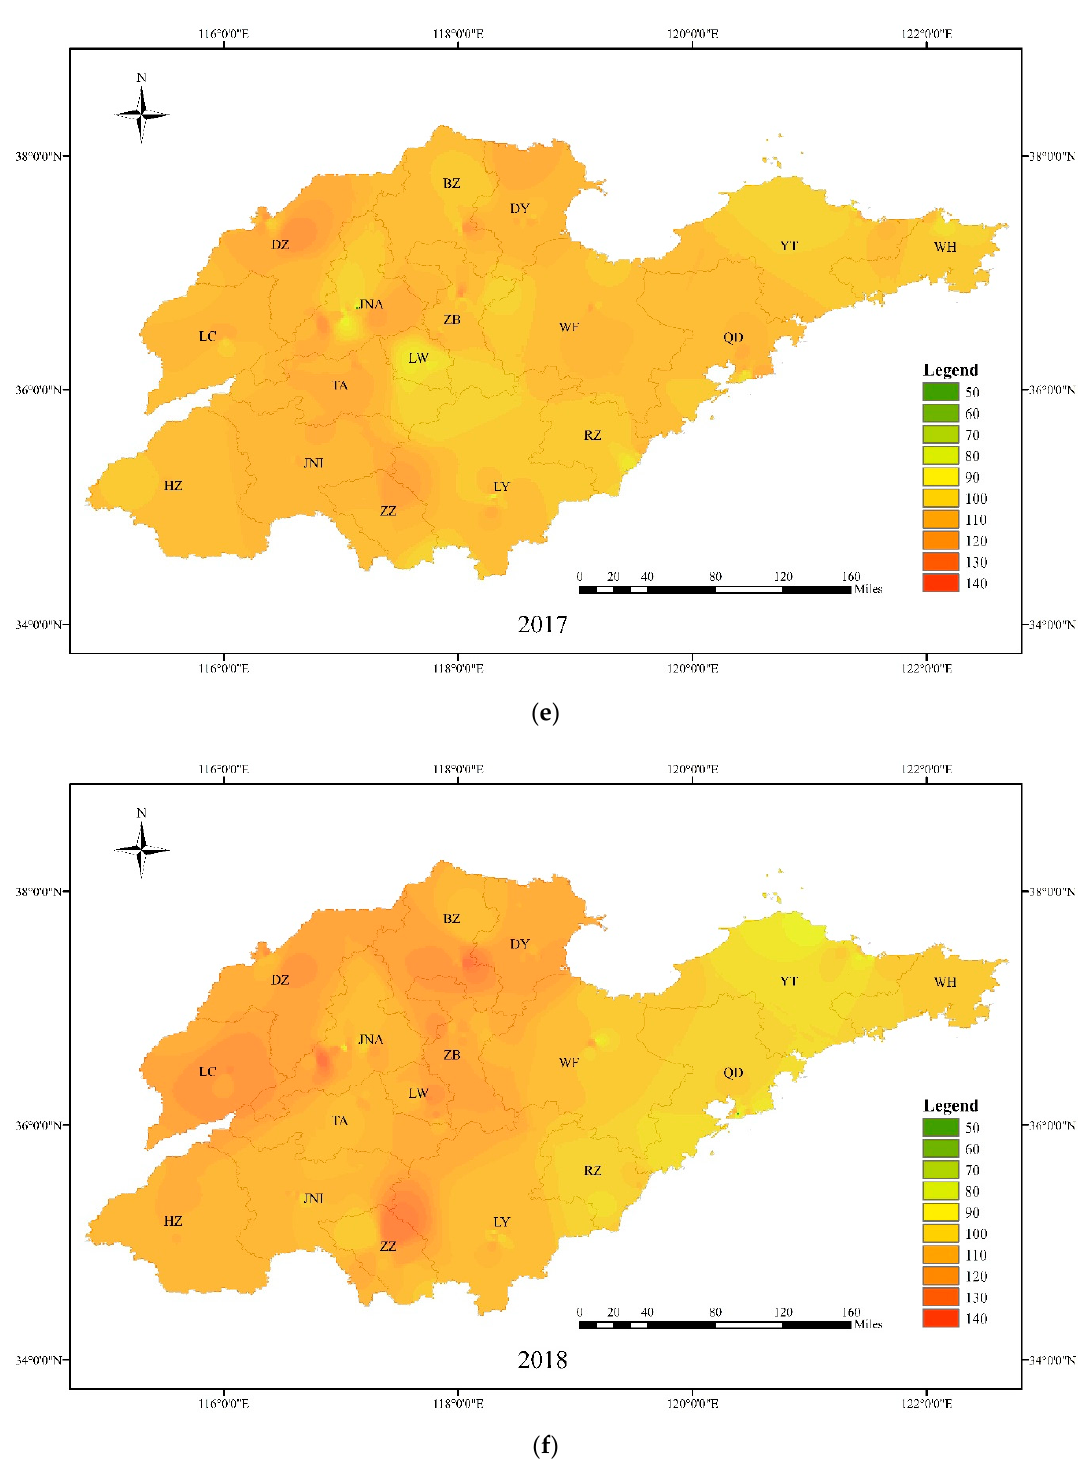
Figure 4. Spatial distribution of ozone concentrations of Shandong province in 2014–2018 (( a ) five years average concentration; ( b ) 2014 average concentration; ( c ) 2015 average concentration; ( d ) 2016 average concentration; ( e ) 2017 average concentration; ( f ) 2018 average concentration).